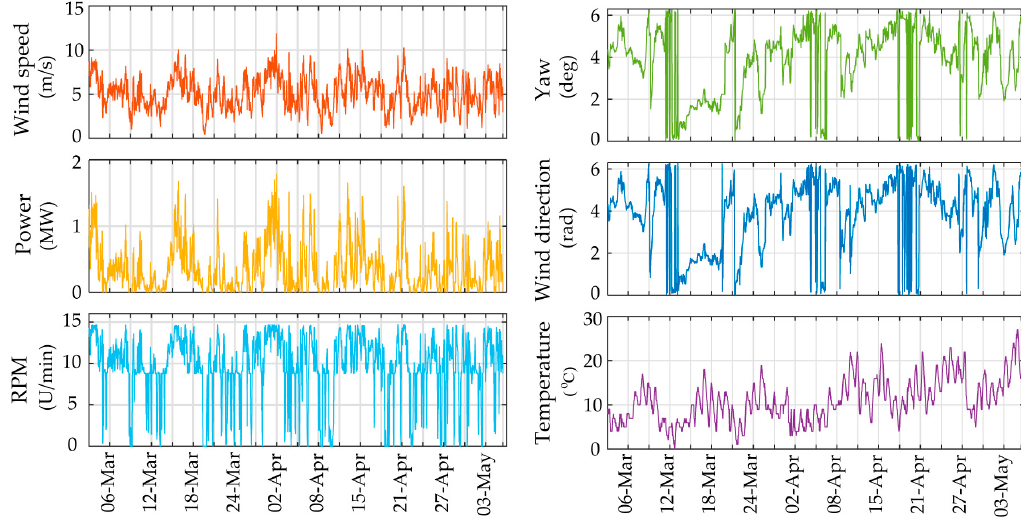
Figure 11. Time history plots of selected PCE input variables for 1388 datasets (Case A).